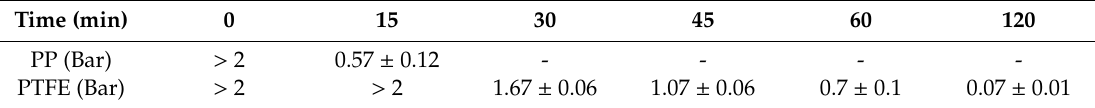
Table 3. Quantitative analysis of PP and PTFE membrane surface